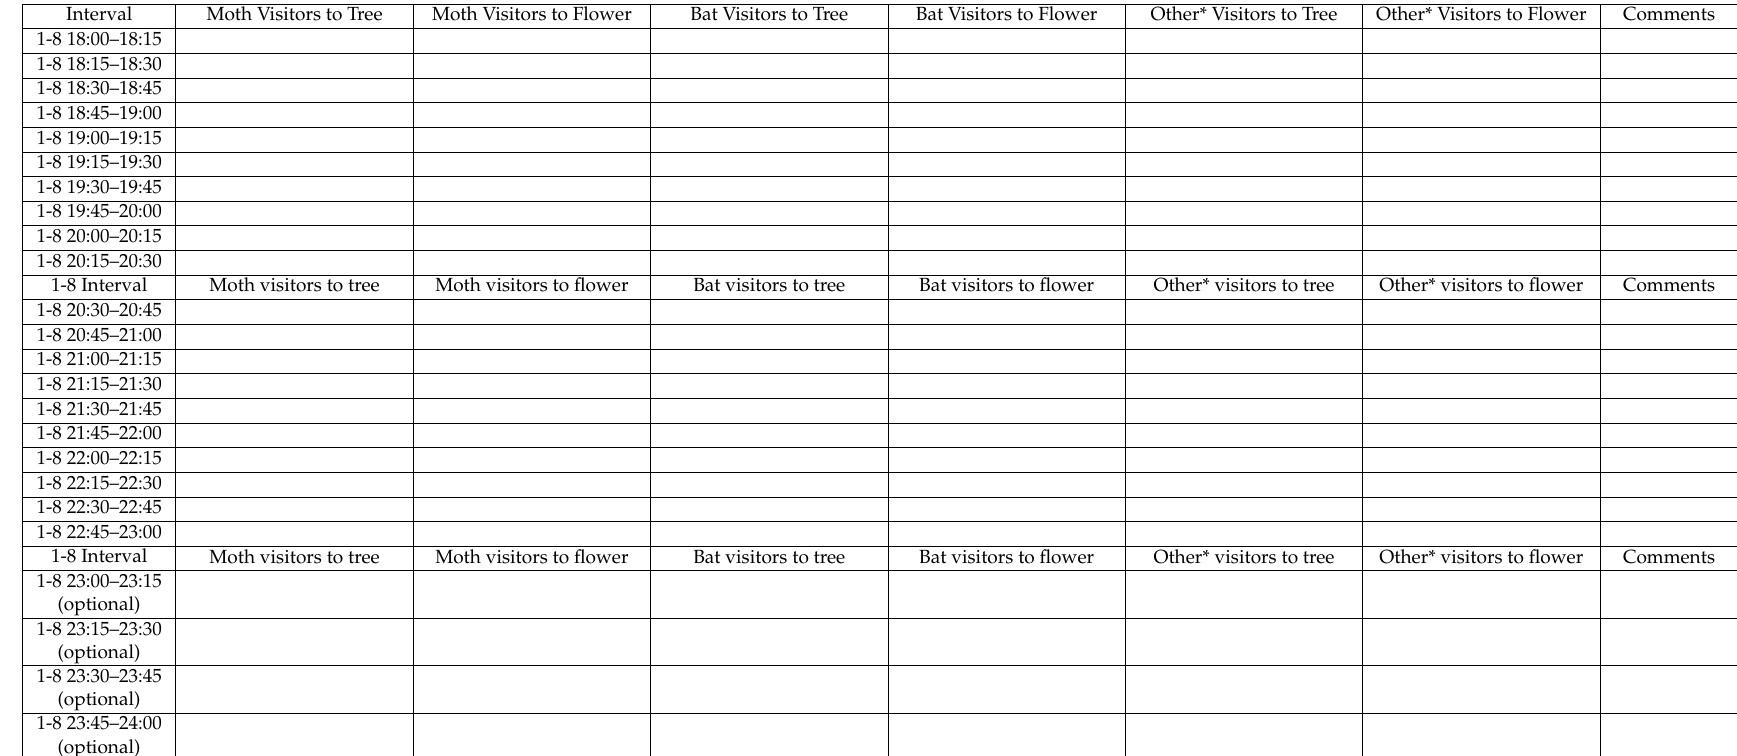
Table A1. Copy of Blank Form Used for Baobab Blitz